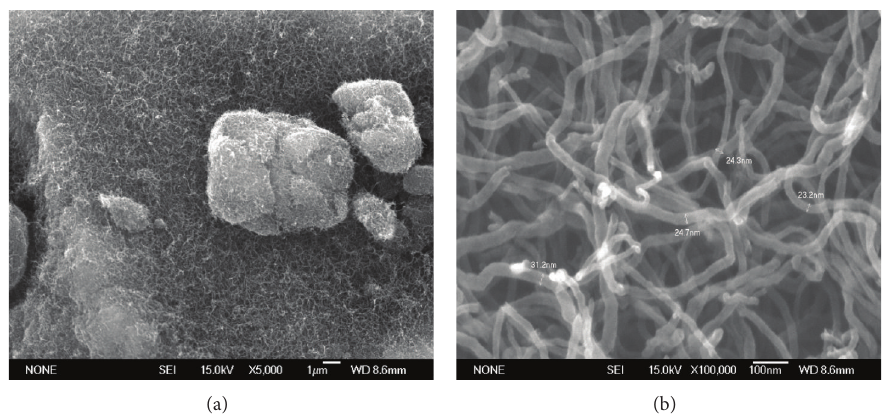
Figure 4: SEM Images of carbon nanotubes at (a) low resolution (b) high resolution.